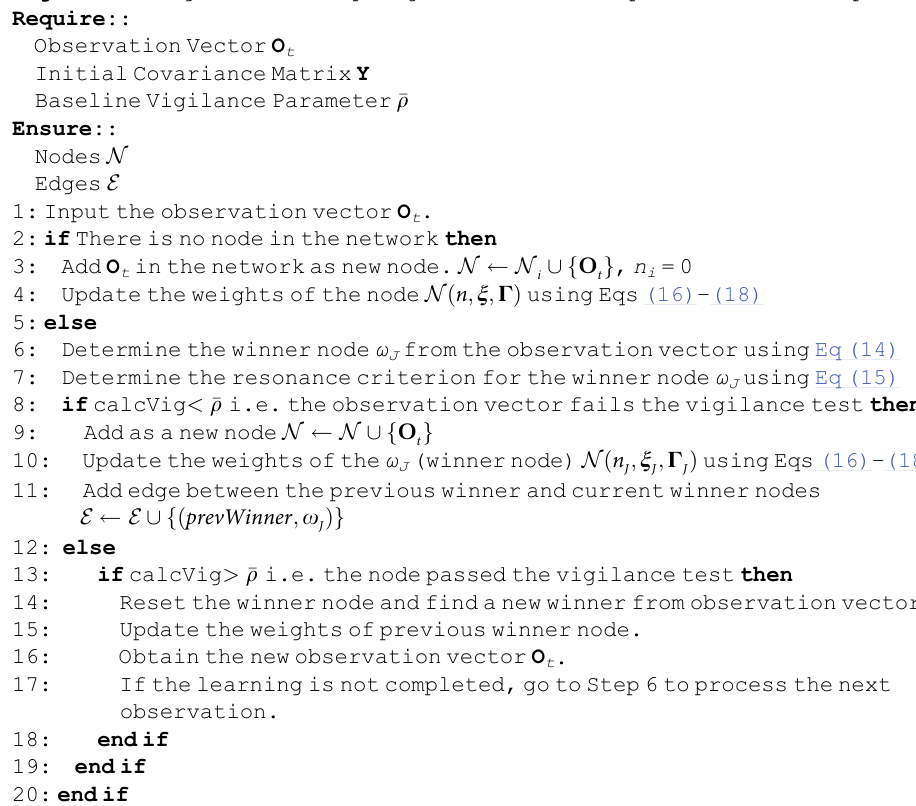
Algorithm 1 Algorithm for Topological Gaussian Adaptive Resonance